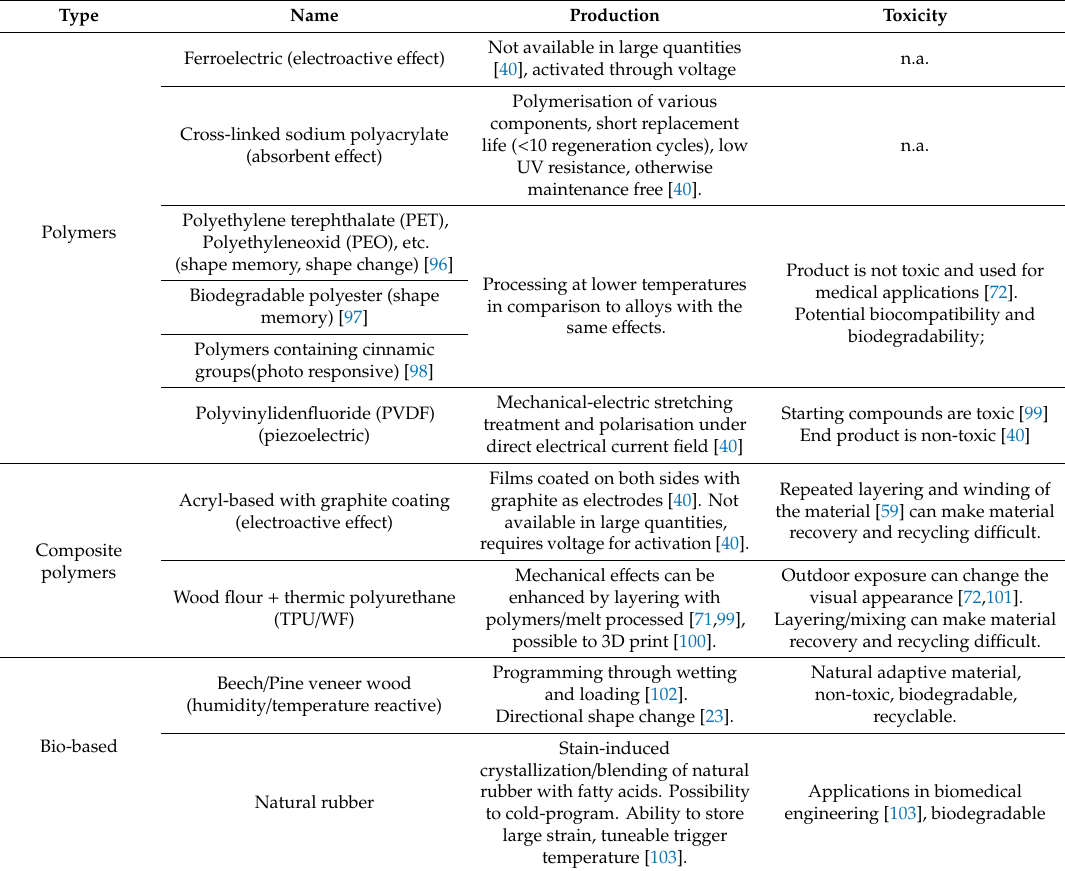
Table 3. Qualitative information on the production of adaptive